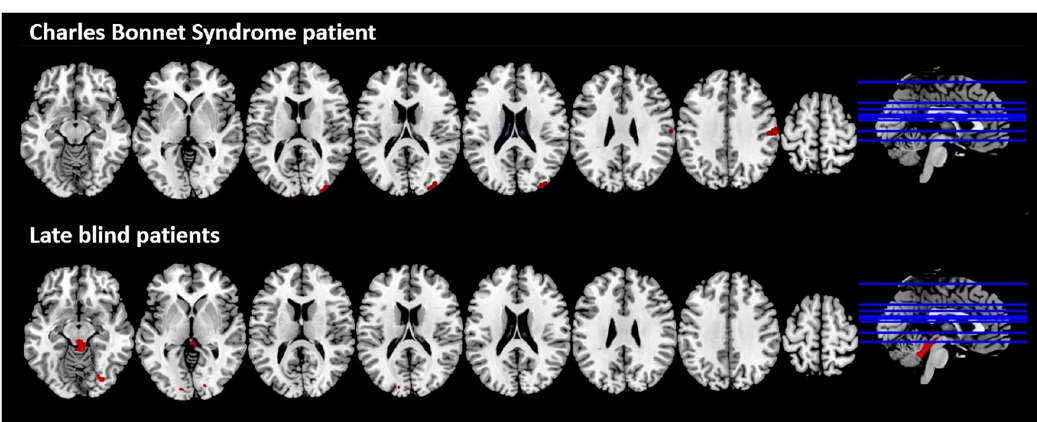
Fig 1. VBM-based grey matter decreases in the CBS patient compared to C-CBS group (top) and in the LB group compared to C-LB group (bottom); multislice view of the regions overlaid on the MNI template; p -uncorrected < 0.001.